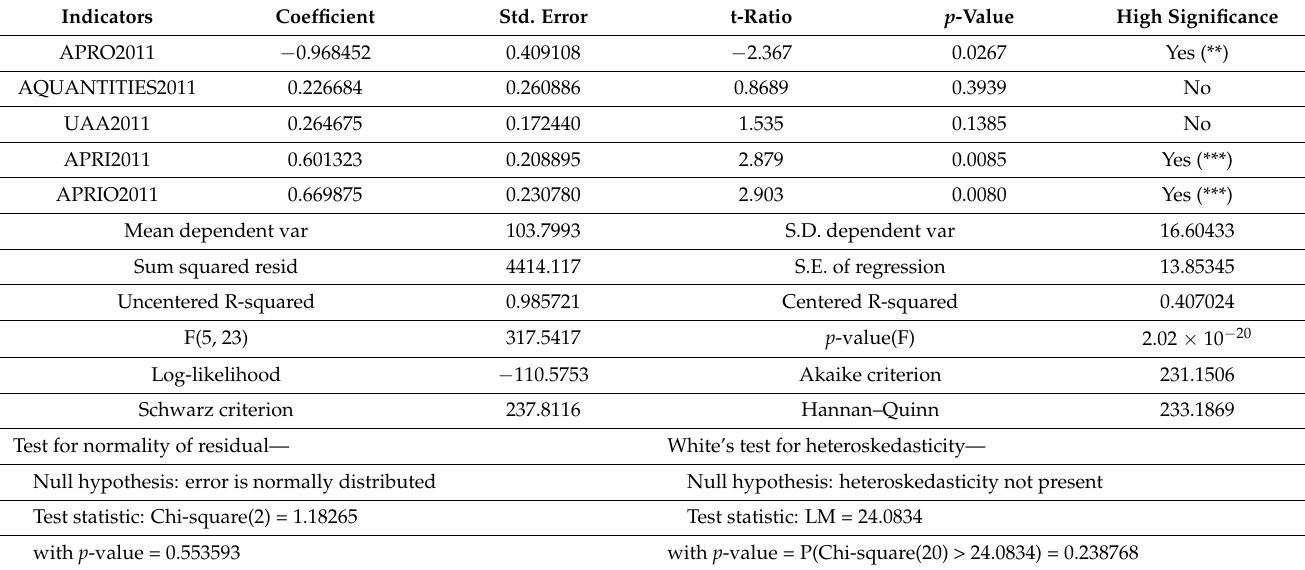
Table 1. Model 2011: OLS, using observations 1–28 (Dependent variable: